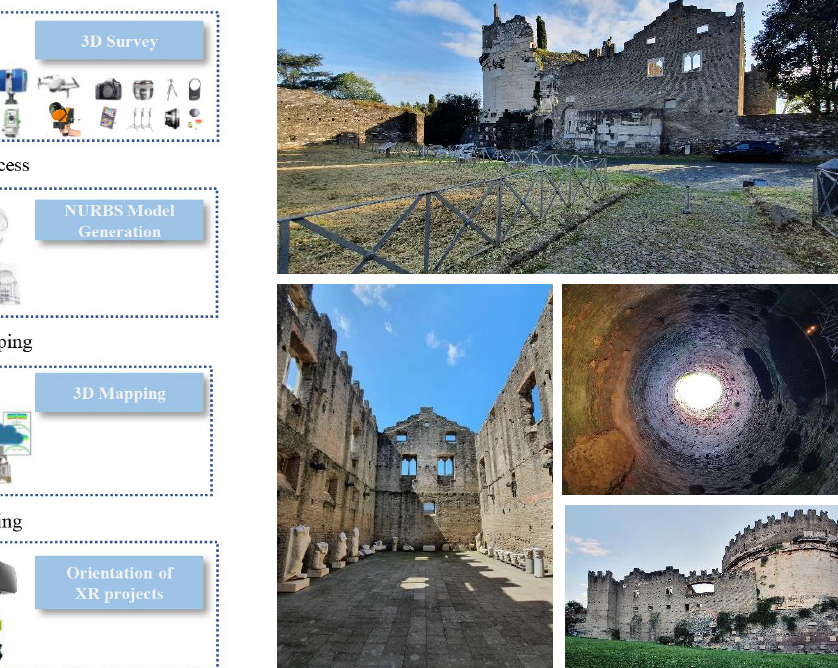
Figure 3. The proposed research process. Figure 4. The research case